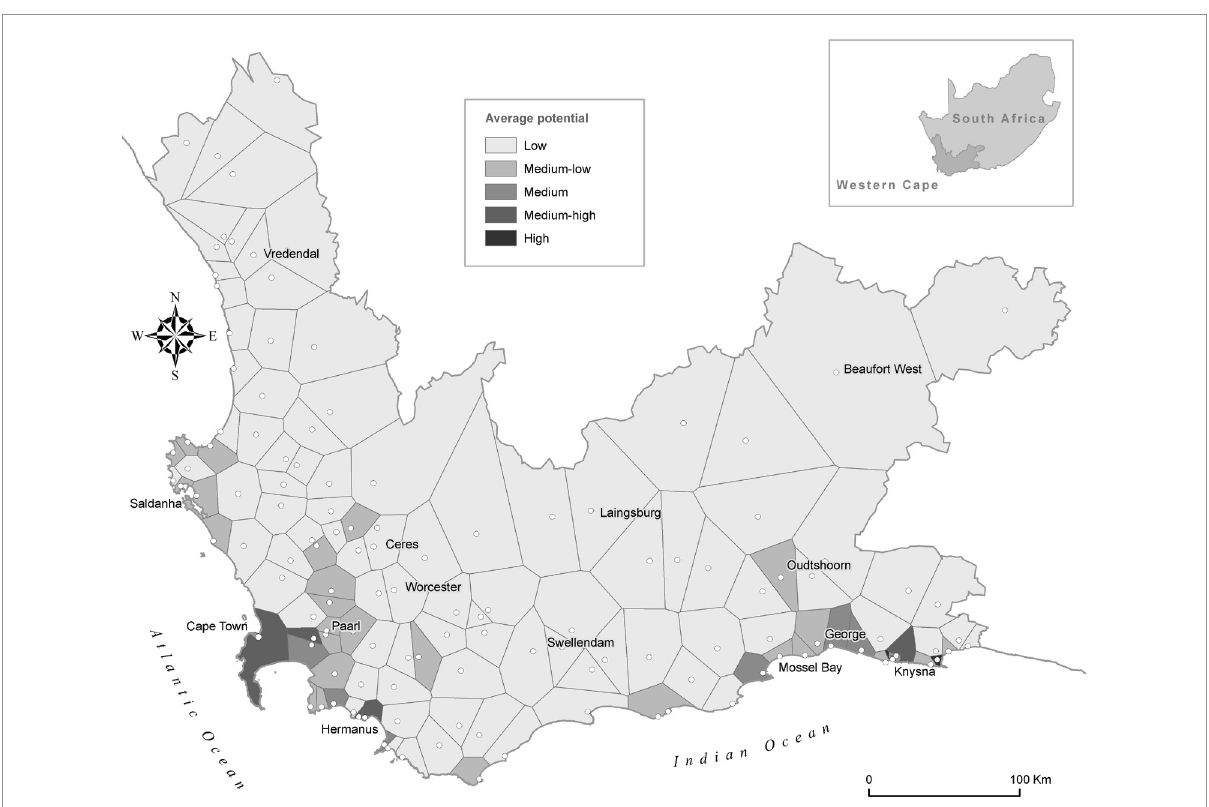
Figure 4: Tourism infrastructure (accommodation) supply per town in the Western Cape